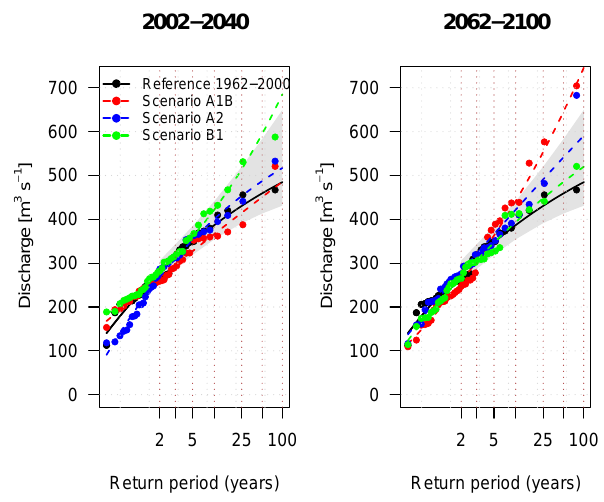
Fig. 9. Annual maximum discharge at Tabreux versus its return pe- riod for the reference period and the climate scenarios shown for the period 2002–2040 (left) and the period 2062–2100 (right). Corre- sponding Generalized Extreme Value (GEV) distributions are fitted to the data. The 95%-confidence interval of the GEV-fit for the ref- erence dataset is plotted as a light gray shaded